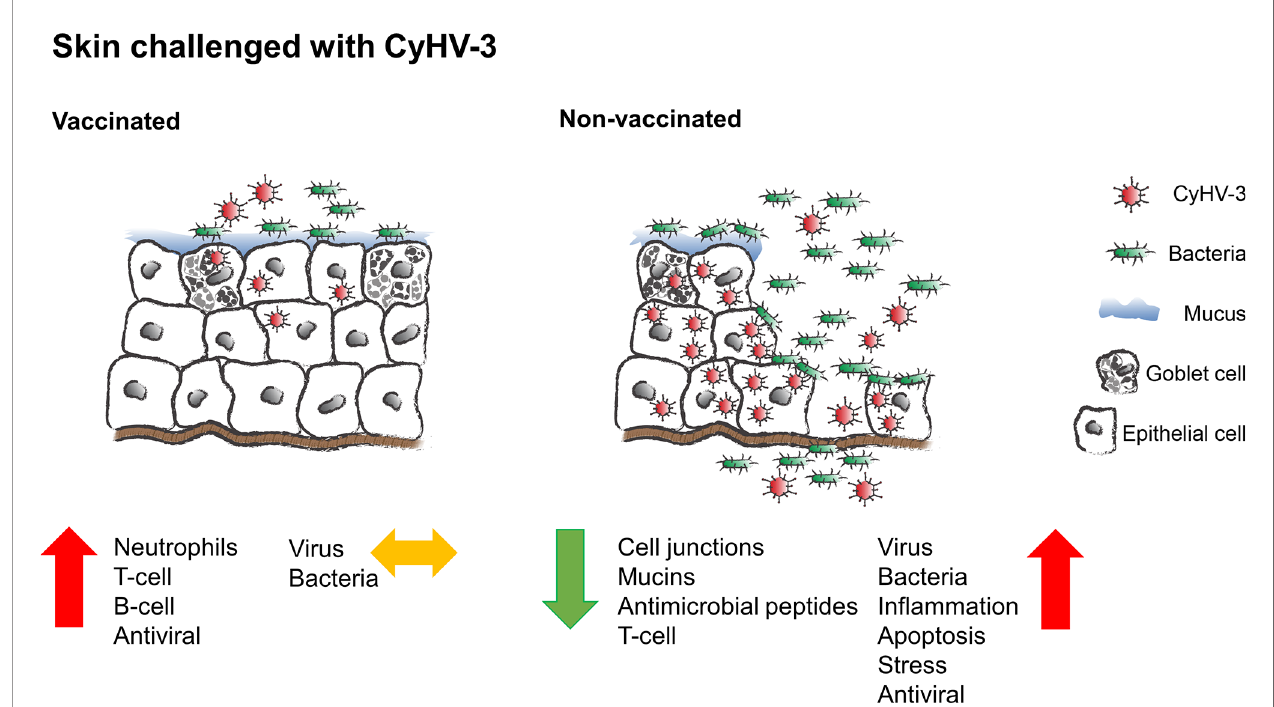
FIGURE 9 | Schematic presentation of the protective effect of vaccination on skin of common carp upon CyHV-3